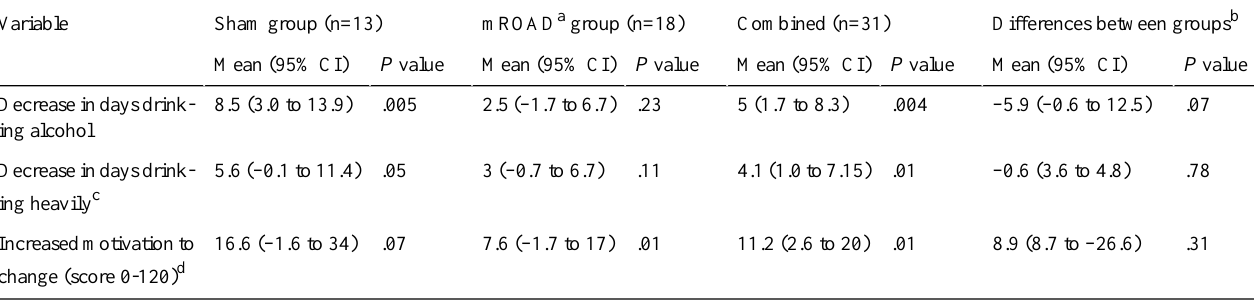
Table 3. Mean changes in drinking habits and desire to change for each group and combined among participants who were followed up.